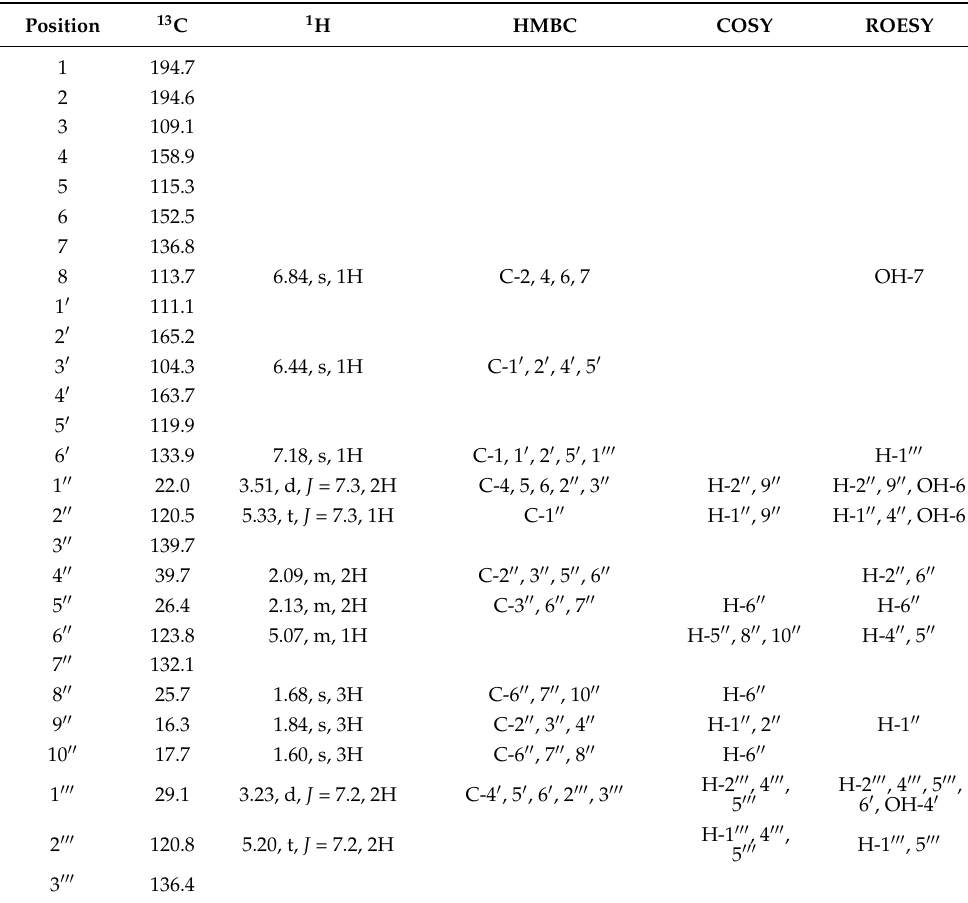
Table 2. 1 H (700 MHz), 13 C (175 MHz), HMBC, COSY, and ROESY NMR data for compound 11 ( δ